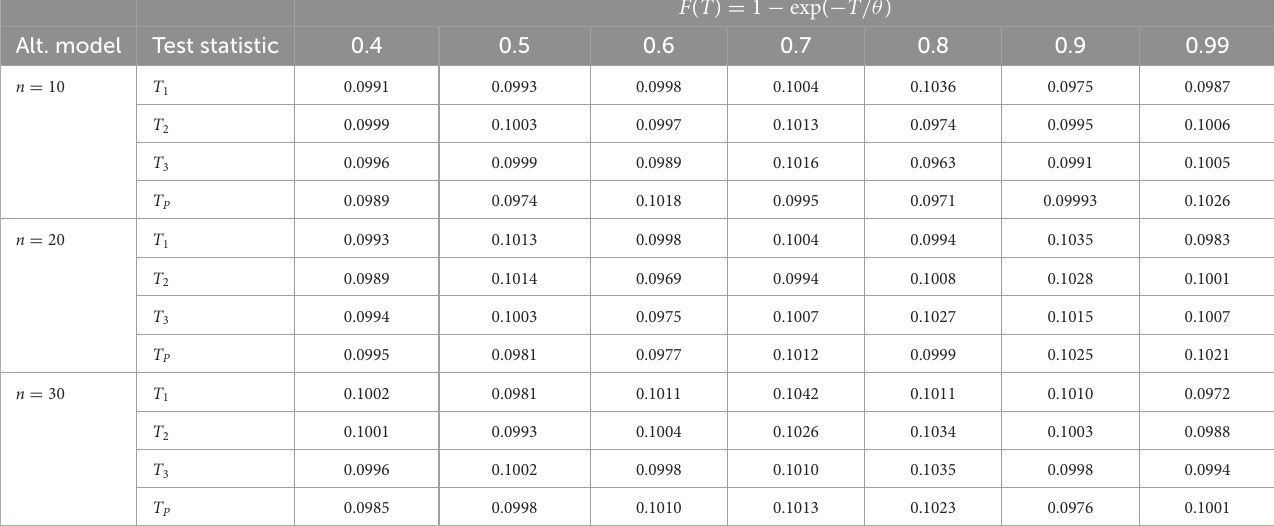
10,20,30 with α 0.10 and 10 5 = =